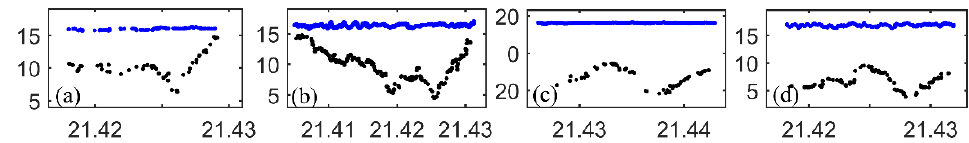
Figure 11. Detection results of reflected photons on the sea surface and seabed in the Oahu area; ( a ) 20190908GT1L; ( b ) 20190908GT1R; ( c ) 20200614GT2L; ( d ) 20201205GT1L.